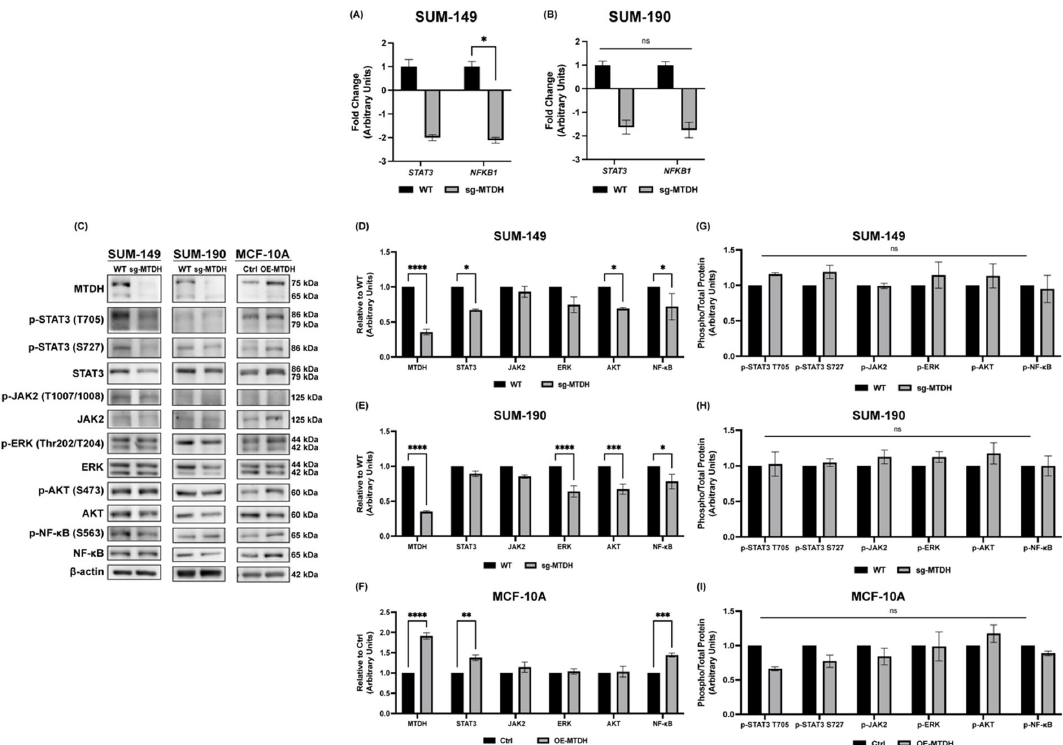
Figure 5. MTDH knockout decreases STAT3, NF ‐κ B, and AKT expression. ( A ) STAT3 and NFKB1 qPCR for SUM ‐ 149 WT and sg ‐ MTDH. ( B ) STAT3 and NFKB1 qPCR for SUM ‐ 190 WT and sg ‐ MTDH. qPCRs were performed using HPRT and RPL13A as reference genes, and changes in gene expression were calculated using the 2 ‐ΔΔ Ct method (* p < 0.05, ns: not significant). ( C ) Immunoblots of whole cell lysates of parental and edited cells of SUM ‐ 149, SUM ‐ 190, and MCF ‐ 10A were performed for the indicated proteins. ( D – I ) Densitometry quantification of total and phospho ‐ proteins in each parental (WT or Ctrl) and edited (sg ‐ MTDH or OE ‐ MTDH) cell lines (SUM ‐ 149, SUM ‐ 190, and MCF ‐ 10A). After the densitometry analysis, the intensities were normalized to their loading control and plotted relative to their parental cells. A two ‐ way ANOVA with Bonferroni’s multiple comparison test was performed; * p < 0.05, ** p < 0.01, *** p < 0.001 and **** p < 0.0001, ns: not significant. Results are shown as Mean ± SEM. The experiments were carried out at least three times.